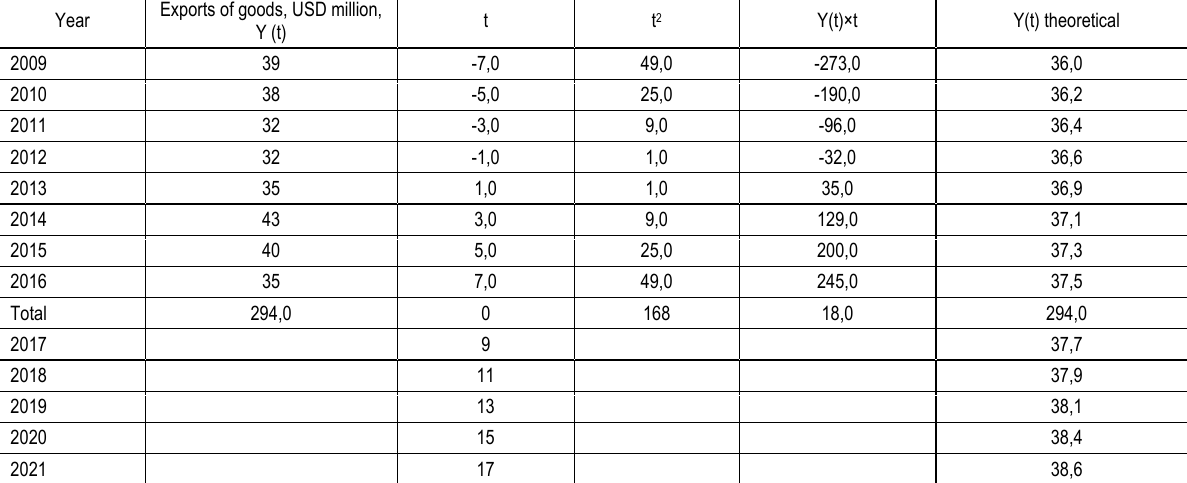
Table 3. Forecast calculations of the shadow economy level in Ukraine for the period 2017 – 2021, % of